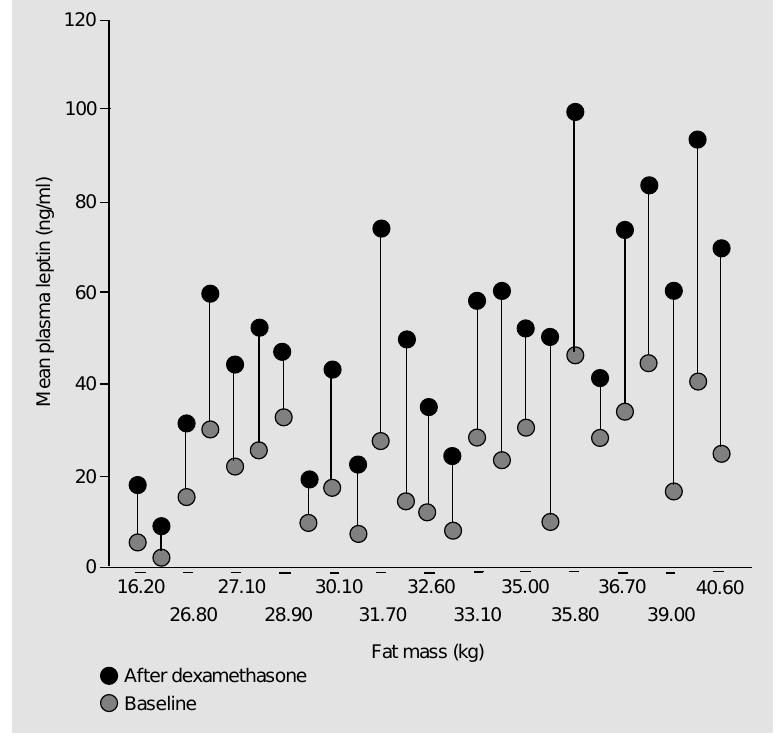
Figure 1 - Increase in serum leptin after dexamethasone treatment. Leptin variation was plotted against basal fat mass for 25 obese subjects.